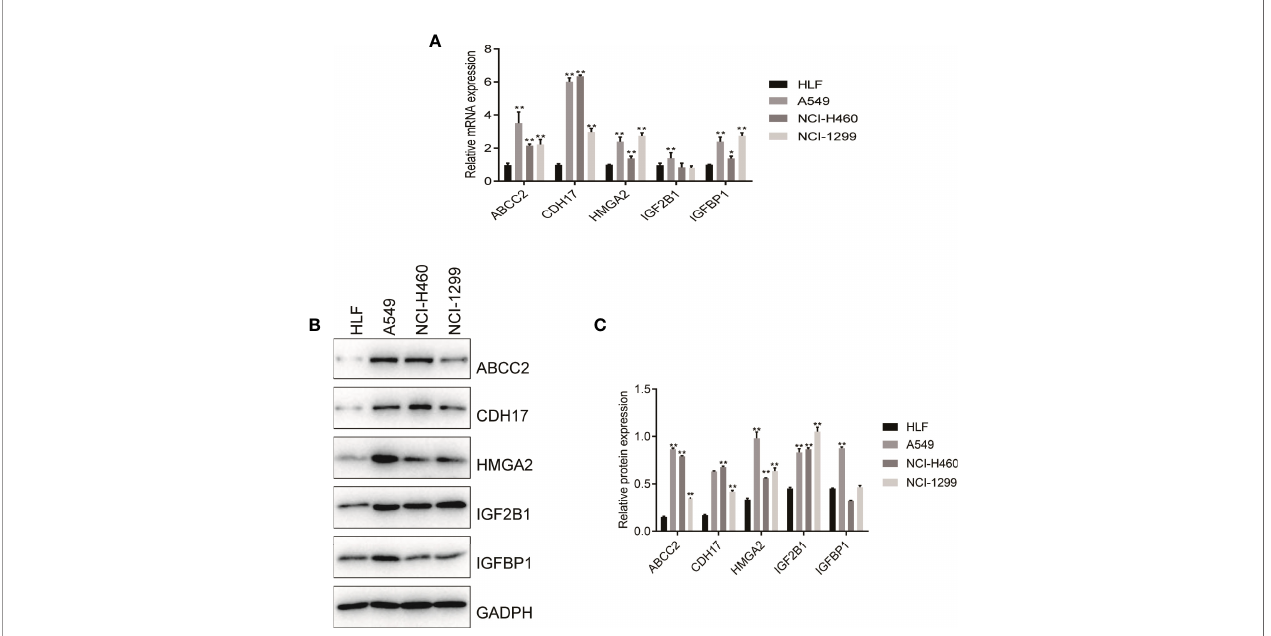
FIGURE 9 | RT-PCR and Western blot veri fi ed the expression level of nitrogen metabolism related genes in lung adenocarcinoma. (A) RT-PCR veri fi ed the mRNA expression of NM-related genes in normal human cell and in tumor cells. (B, C) Western blot validated protein of NM-related genes expressing levels in normal human cell and in tumor